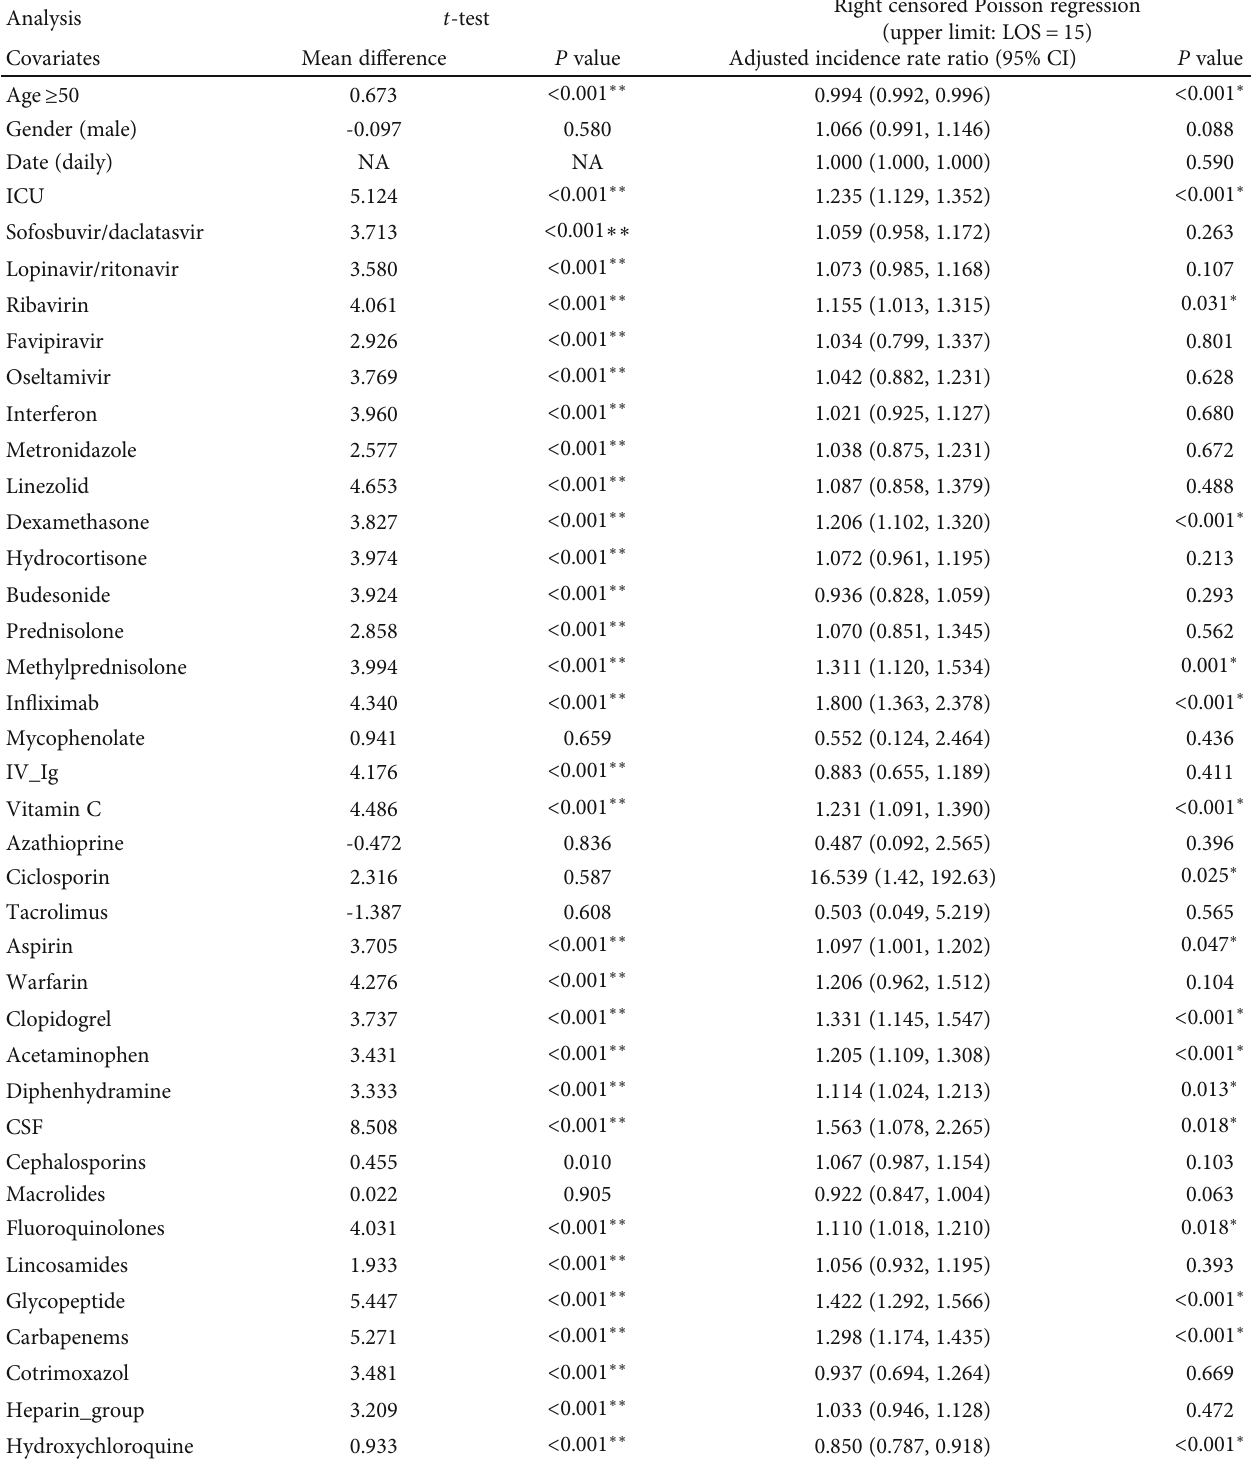
Table 6: Association of the variables with LOS in survived cases using the independent t -test and right censored Poisson regression (in hospitalized improved cases; the other cases were